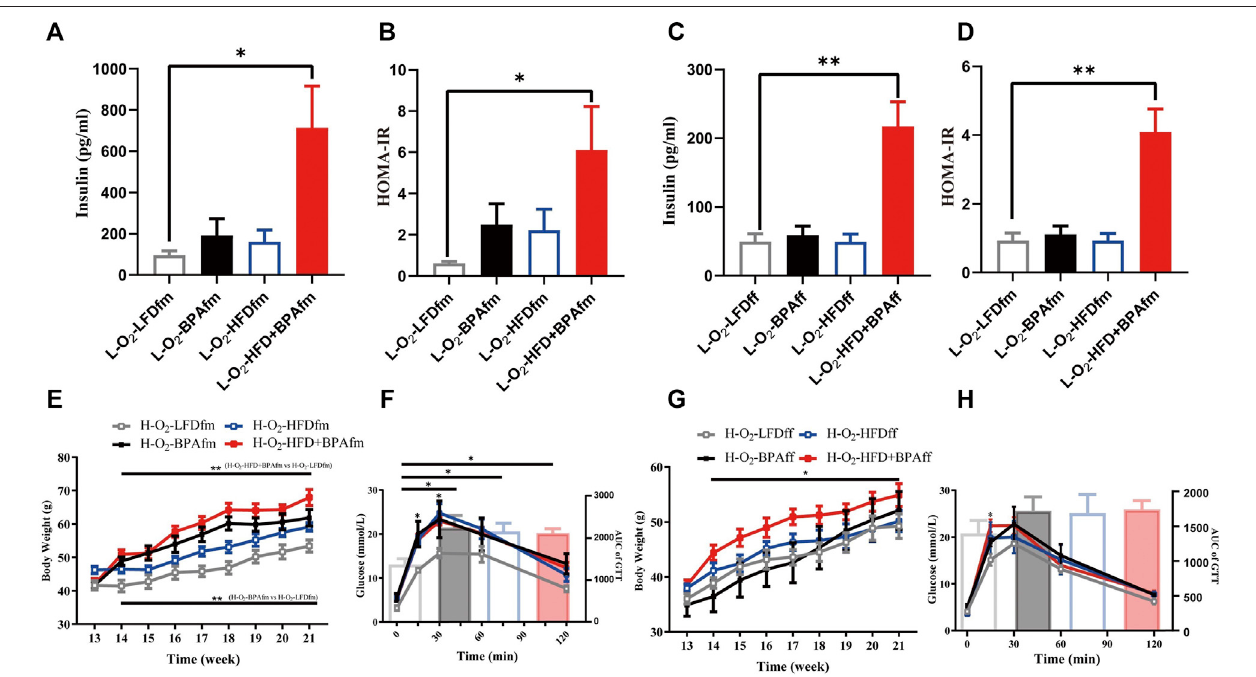
FIGURE 6 | Effects of combined exposure to BPA and HFD on insulin of matrilineal F2 and their metabolic pro fi le for exposing HFD again. (A – D) Serum insulin concentration and insulin resistance index. (E – H) Body weight and glucose tolerance of maternal F2 when exposed to HFD again. Data are means ± SEMs and were analyzed by two-way ANOVA with a posthoc test. * p < 0.05, ** p < 0.01, BPA, HFD, BPA + HFD vs LFD.